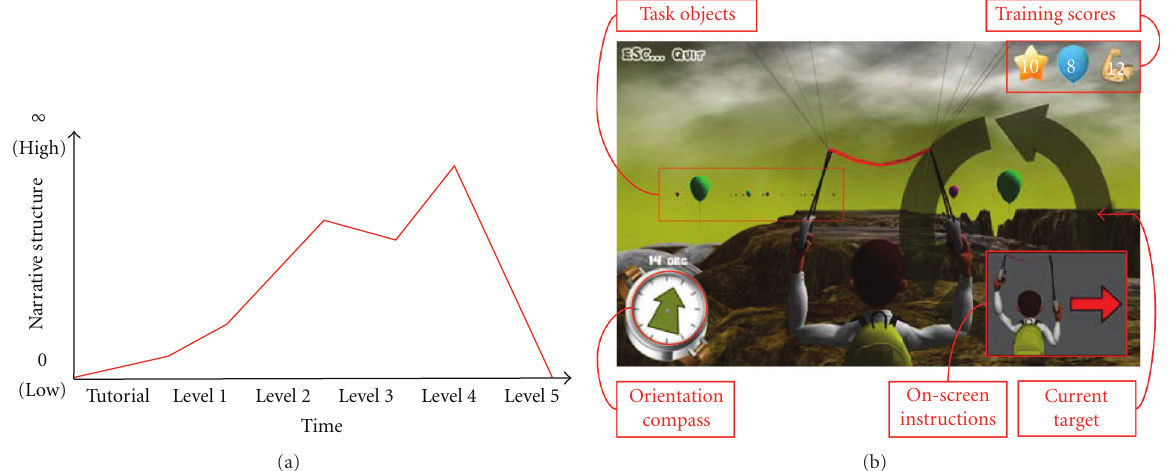
Figure 3: Game design elements of the Neurorehabilitation Training Toolkit (NTT). (a) Curve describing the narrative structure of the NTT where the di ff erent game levels are assigned to a narrative (interest) value. (b) Snapshot of the NTT training scenario during a game play. Task and feedback elements are indicated.